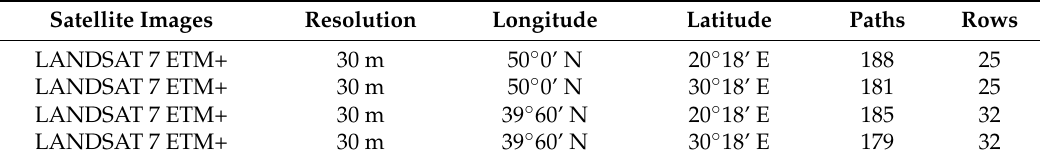
Table 1. Landsat 7 ETM+ image paths, rows Satellite Images